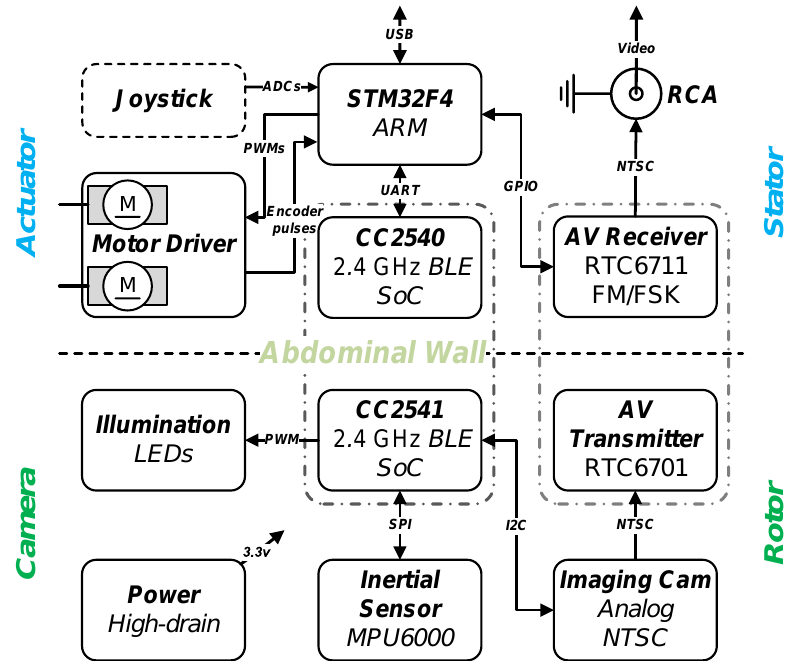
Figure 6. s-CAM electronic system architecture block